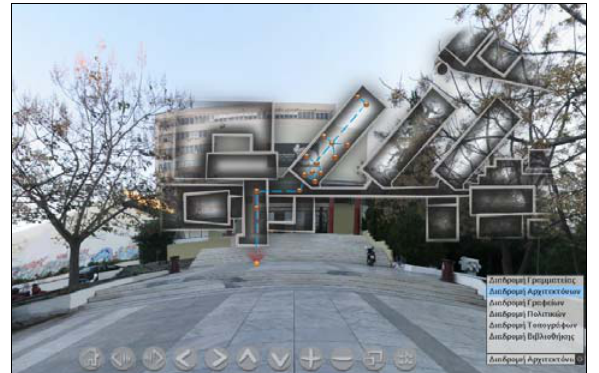
Figure 17. Information appears when the cursor is over of specific